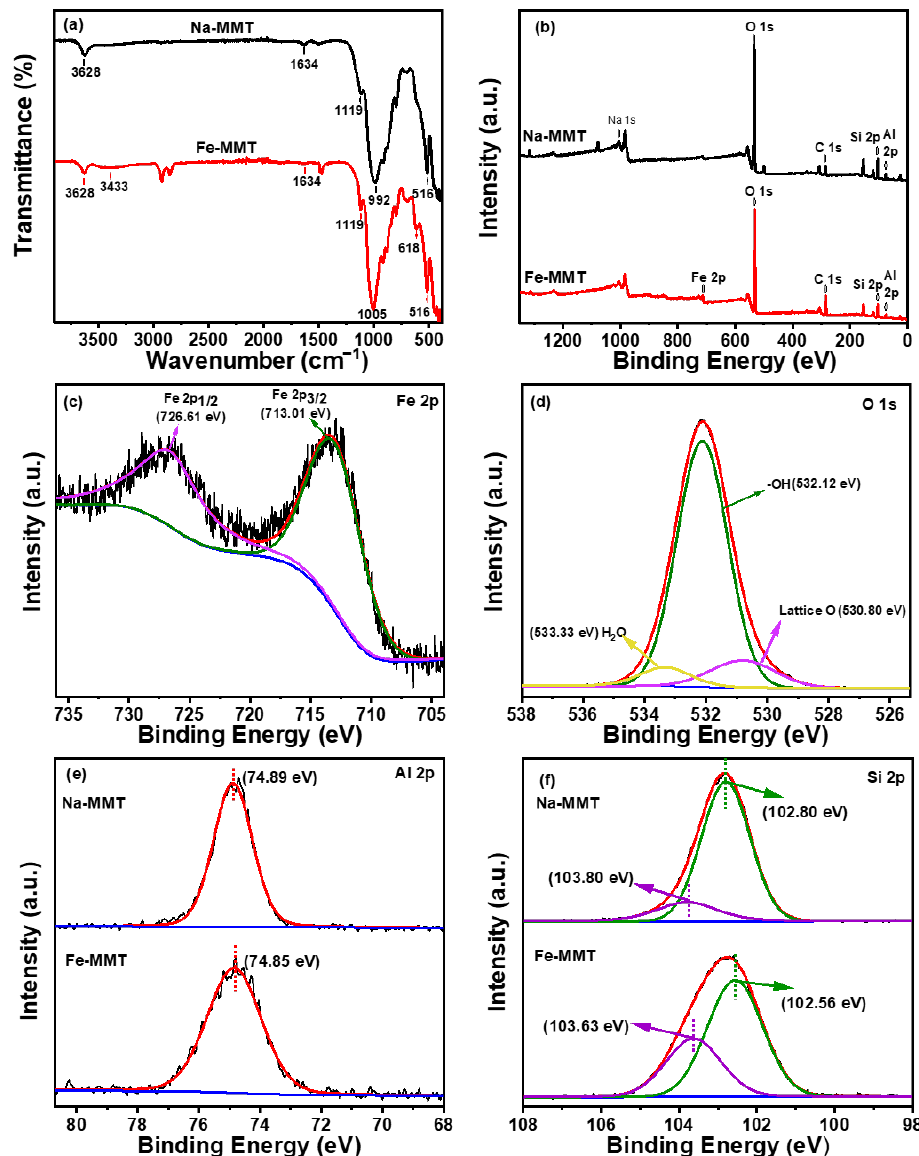
Figure 3. ( a ) FT-IR spectrum and ( b ) survey XPS spectrum of Na-MMT and Fe-MMT. High-resolution XPS spectrum of ( c ) Fe 2p, ( d ) O 1s for Fe-MMT, ( e ) Al 2p and ( f ) Si 2p for Na-MMT and Fe-MMT. Table 2. The binding energies corresponding to some of the peaks in the XPS spectra.